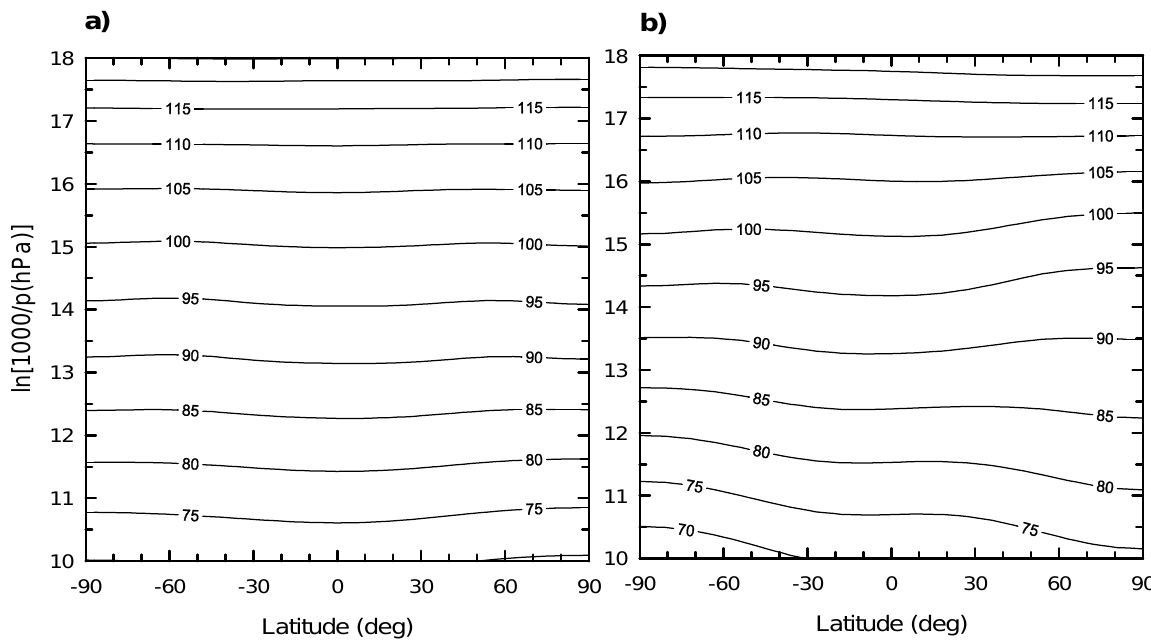
Fig. 1. Relationship between geometrical (inkm) and log-pressure coordinates in the UMLT region for 16 March ( a ) and 1 July ( b ) from the MSISE-90 model (Hedin,